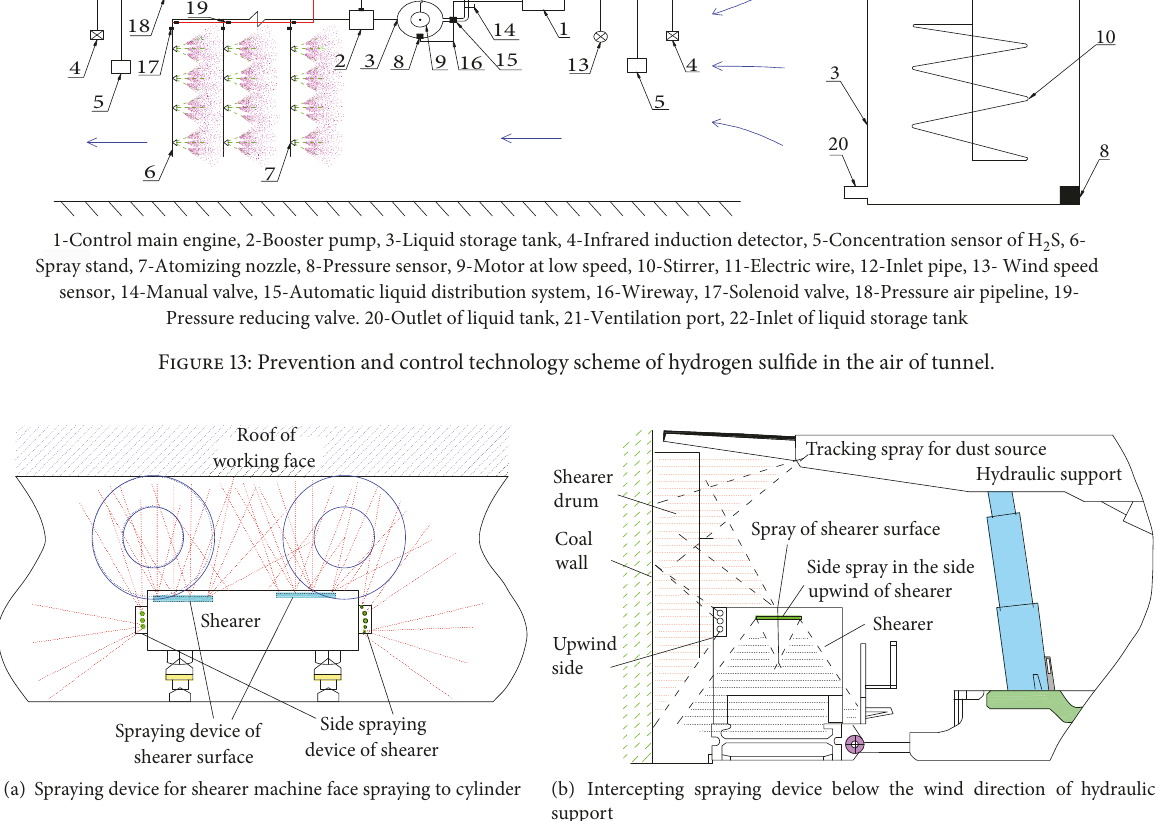
Figure 14: Spraying absorption liquid to control the coal mining machine to disturb the hydrogen sulfide